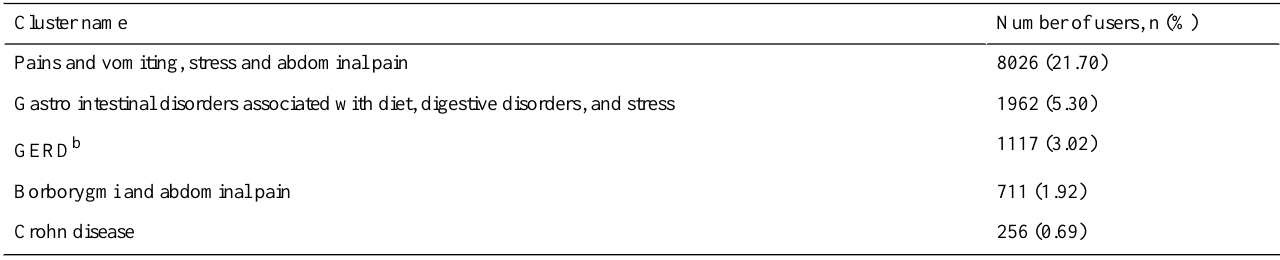
Table 4. List of main clusters of web users that were identified (36,989 users).